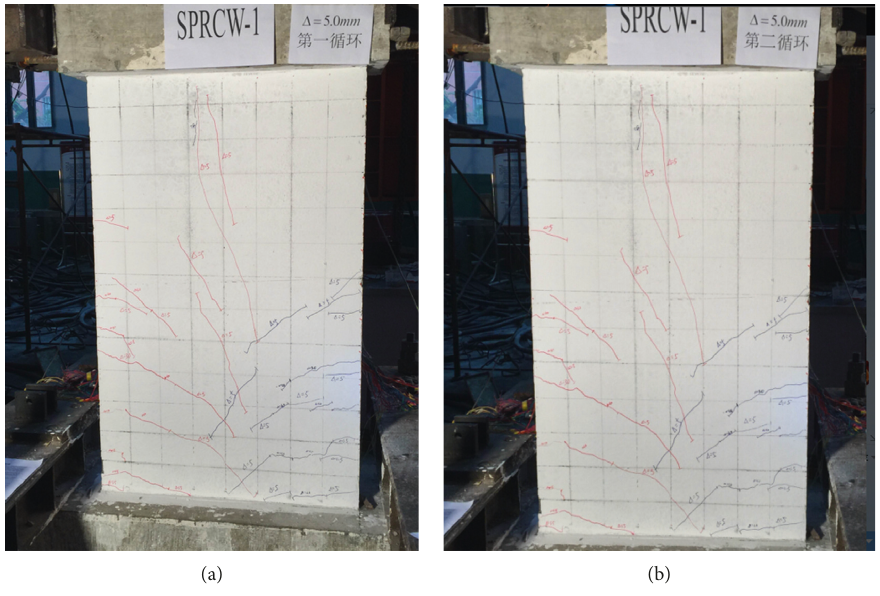
Figure 6: Cracks in the Δ � 5mm displacement cycle. (a) First cycle. (b) Second